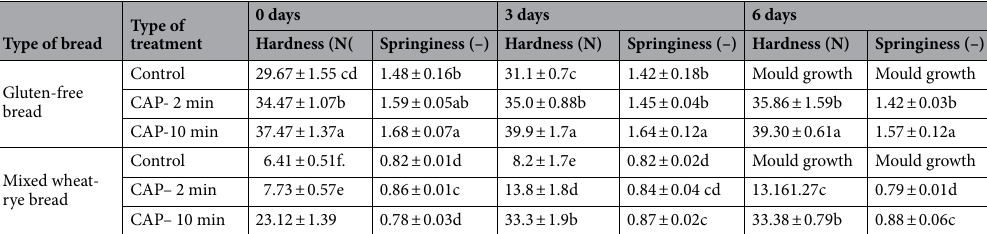
Table 2. Changes in the texture of bread treated with cold atmospheric plasma. *Mean values in the same column marked with different letters are significantly (α = 0.05)